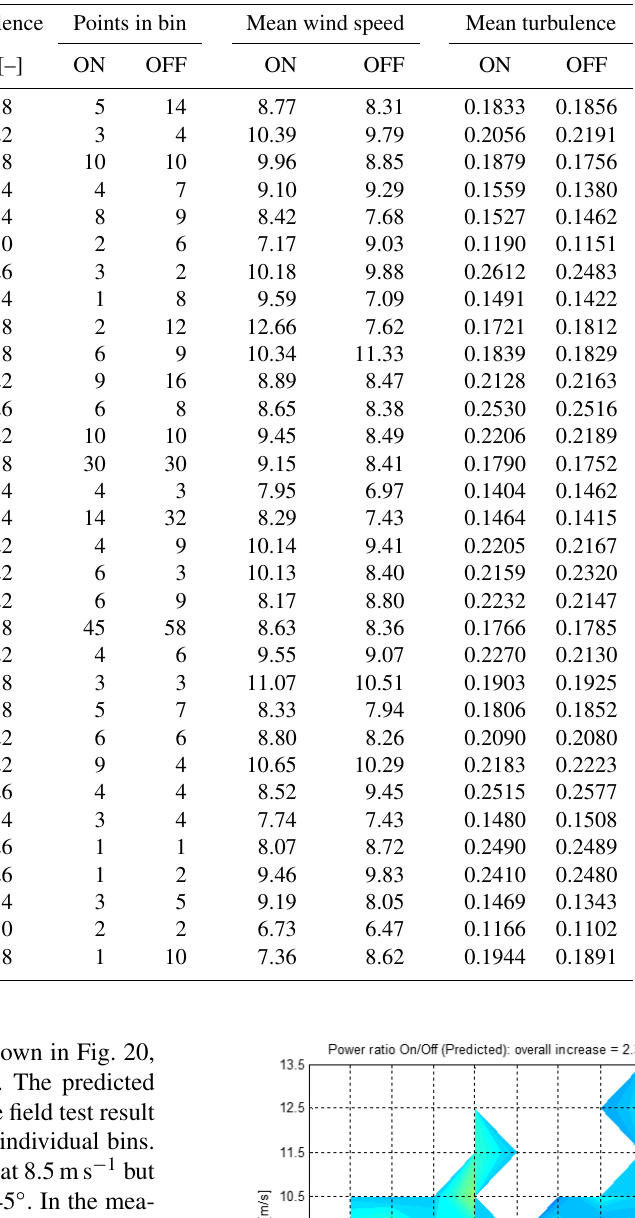
Table 3. Statistics of populated bins in Fig. 19 (ordered by the normalised power ratio).